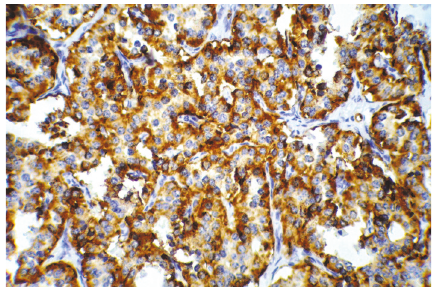
Figure 5: IHC for chromogranin (one of the endocrine differentia- tion markers) expressed by tumor